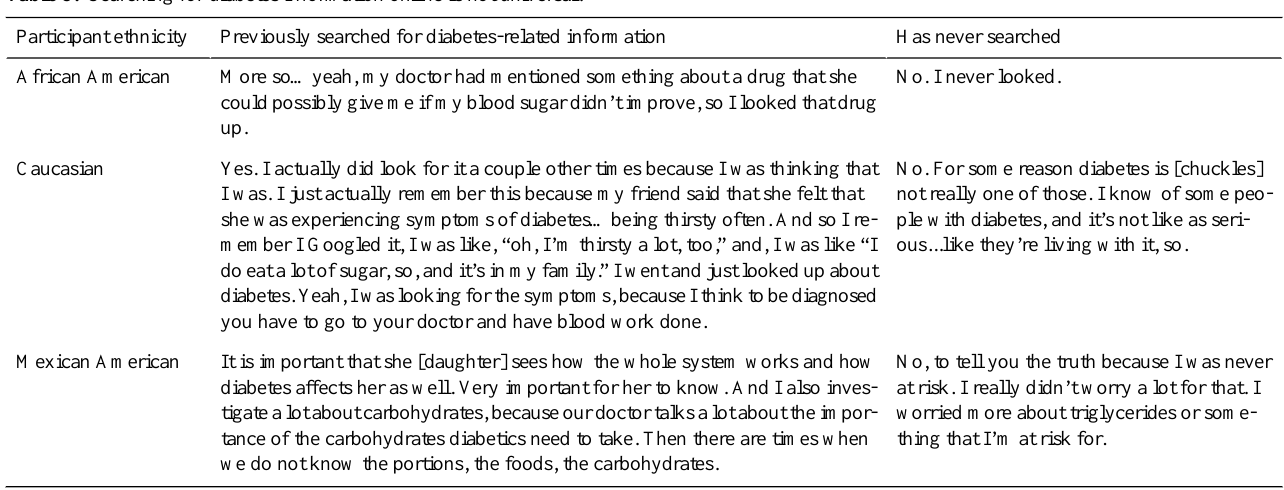
Table 5. Searching for diabetes information online is not